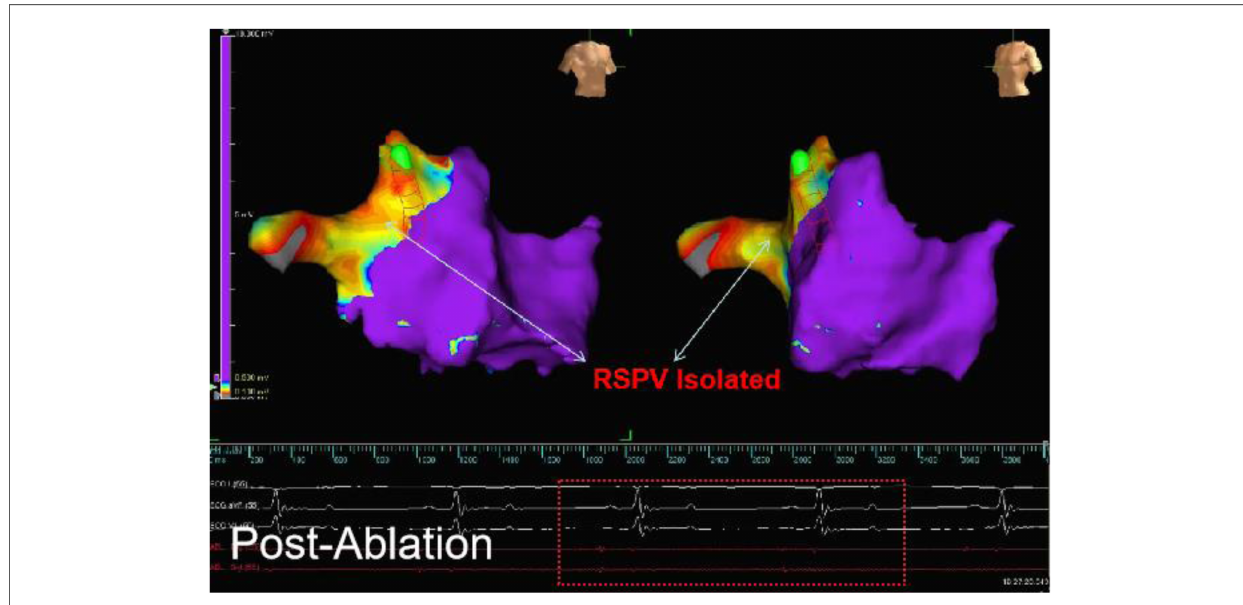
FIGURE 4 The electroanatomical mapping results immediately after surgery (image from dog B2) showed that the left atrial voltage mapping revealed low voltage in the right superior PV (RSPV). The red line frame represents the PV electrical signal after ablation, and the absence of far- fi eld potential from the left atrium in PV indicates successful afferent